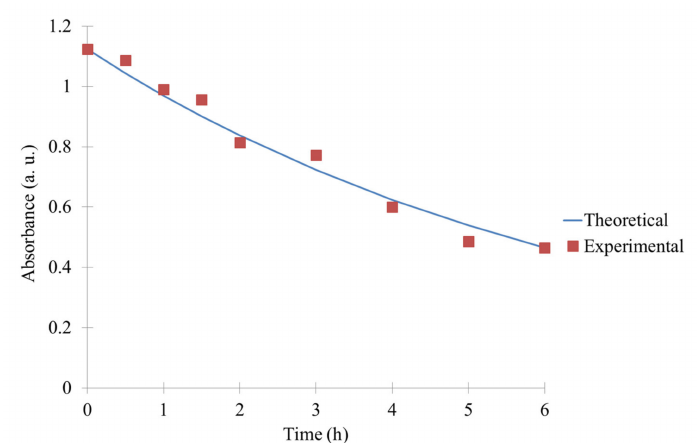
Figure 6. Kinetic analysis of the MB degradation for TiO 2 / SiO 2 / Pd1 sample: (-) theoretical evolution and ( (cid:4) ) experimental